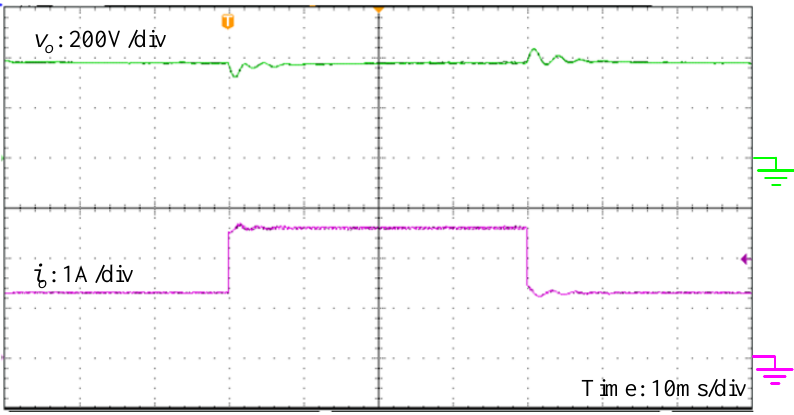
Figure 16. Output voltage response with step load change.